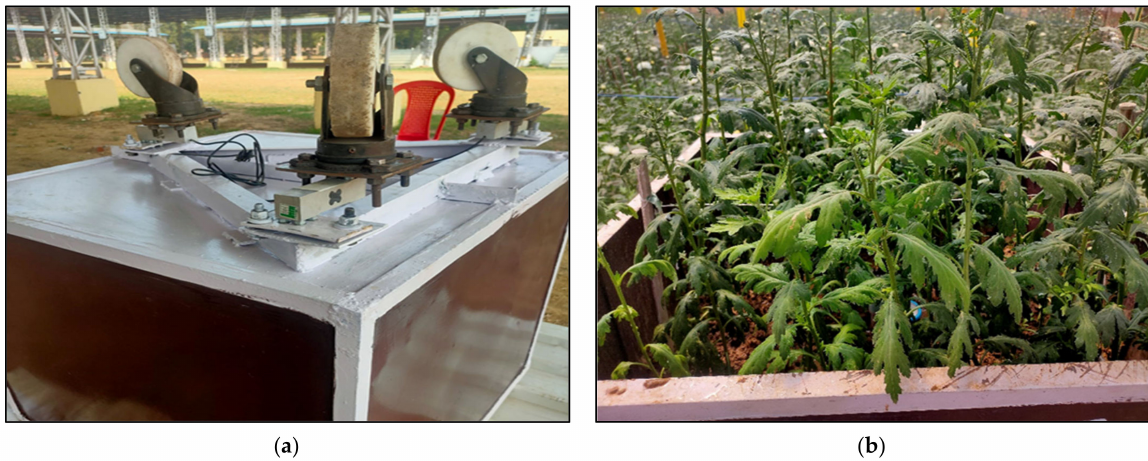
Figure 7. ( a ) Triangular arrangement of wheels at the bottom of the lysimeter; ( b ) the lysimeter installed in the greenhouse and crops are